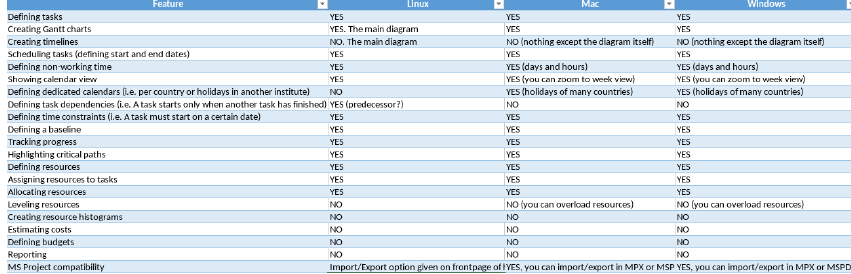
The evaluated tools were: